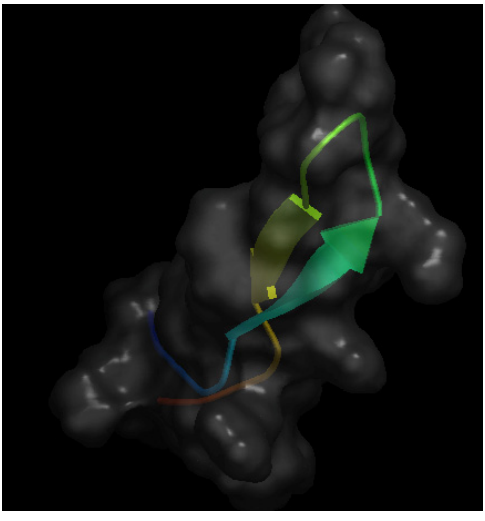
Figure 3. Schematic representation of the 3-D structure of bovine lactoferricin in solution solved by NMR. The file with pdb ID 1lfc was retrieved from protein data bank [16] and visualized with Open Astex Viewer maintaining the protein on a black background and representing the protein surface in grey with a 30% of